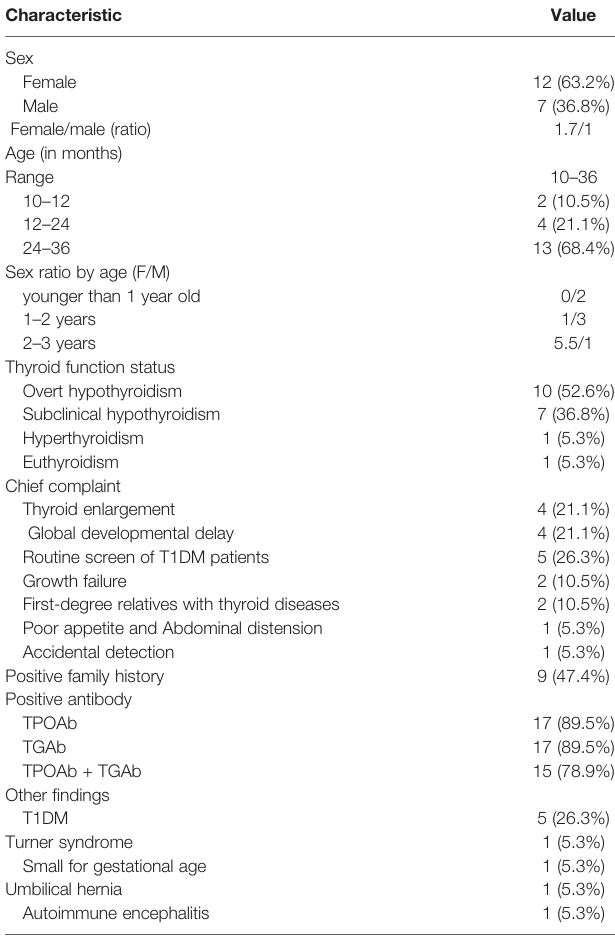
TABLE 1 | Characteristics of the 19 children with